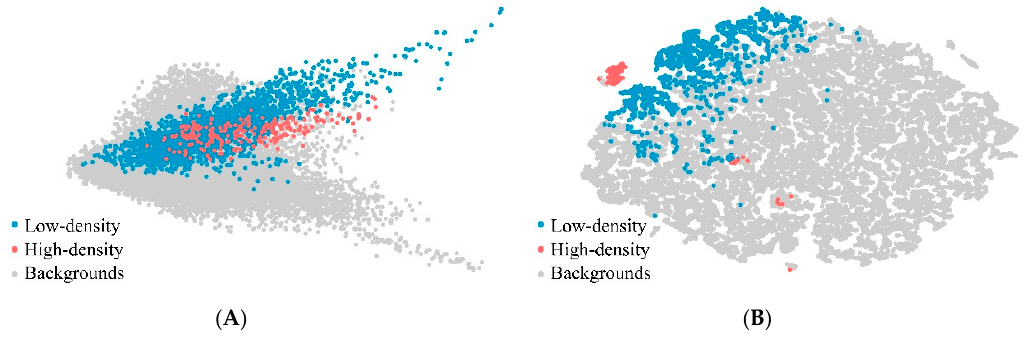
Figure 6. Visualization of test set samples before ( A ) and after recalibration ( B ) with SE block. Di ff erent